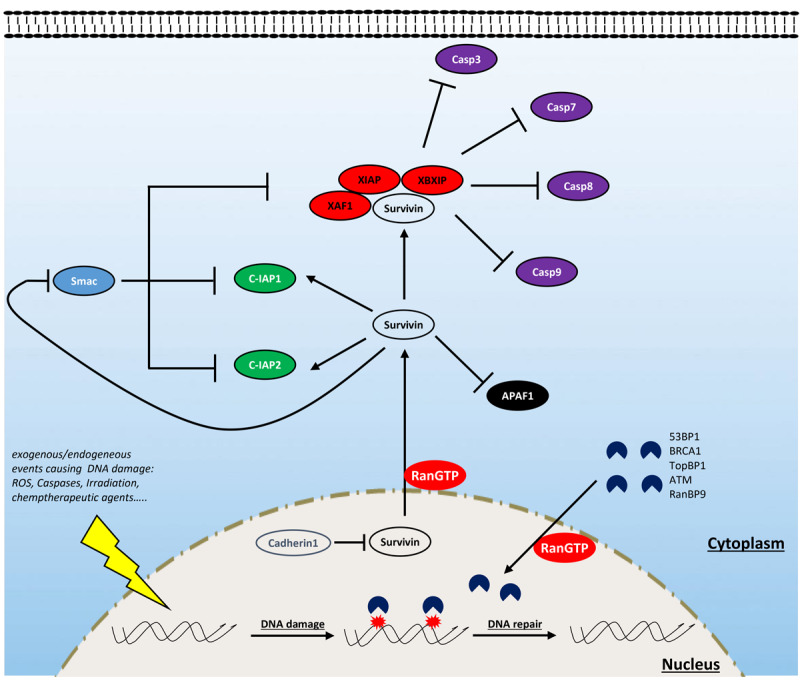
Involvement of Ran in resisting cell death. Ran is involved in resisting cell death through the interaction with survivin and some components of the DNA damage response (DDR). Ran participates in the export of survivin from the nucleus (which is rapidly destabilized by cadherin 1) to the cytoplasm. Cytoplasmic survivin plays a critical role in cell survival by inhibiting proapoptotic factors: while it participates in the formation of a complex with some inhibitors of apoptosis proteins (IAPs) (notably XAF1, XIAP, and XBXIP) to inhibit the activity of caspases 3, 7, 8, and 9, it enhances the activity of other factors such as C-IAP1 and C-IAP2. Furthermore, survivin antagonizes the release of apoptotic protease-activating factor 1 (APAF1) from the mitochondria and constrains the action of the IAP inhibitor Smac. Ran is also an active player of the DDR which is activated following the exposure of cells to endogenous or exogenous DNA-damaging factors [i.e., reactive oxygen species (ROS), caspases, irradiation, and chemotherapy]. During this process, Ran participates in the import of critical components of the DDR such as ATM, BRCA1, TopBP1, and 53BP1.